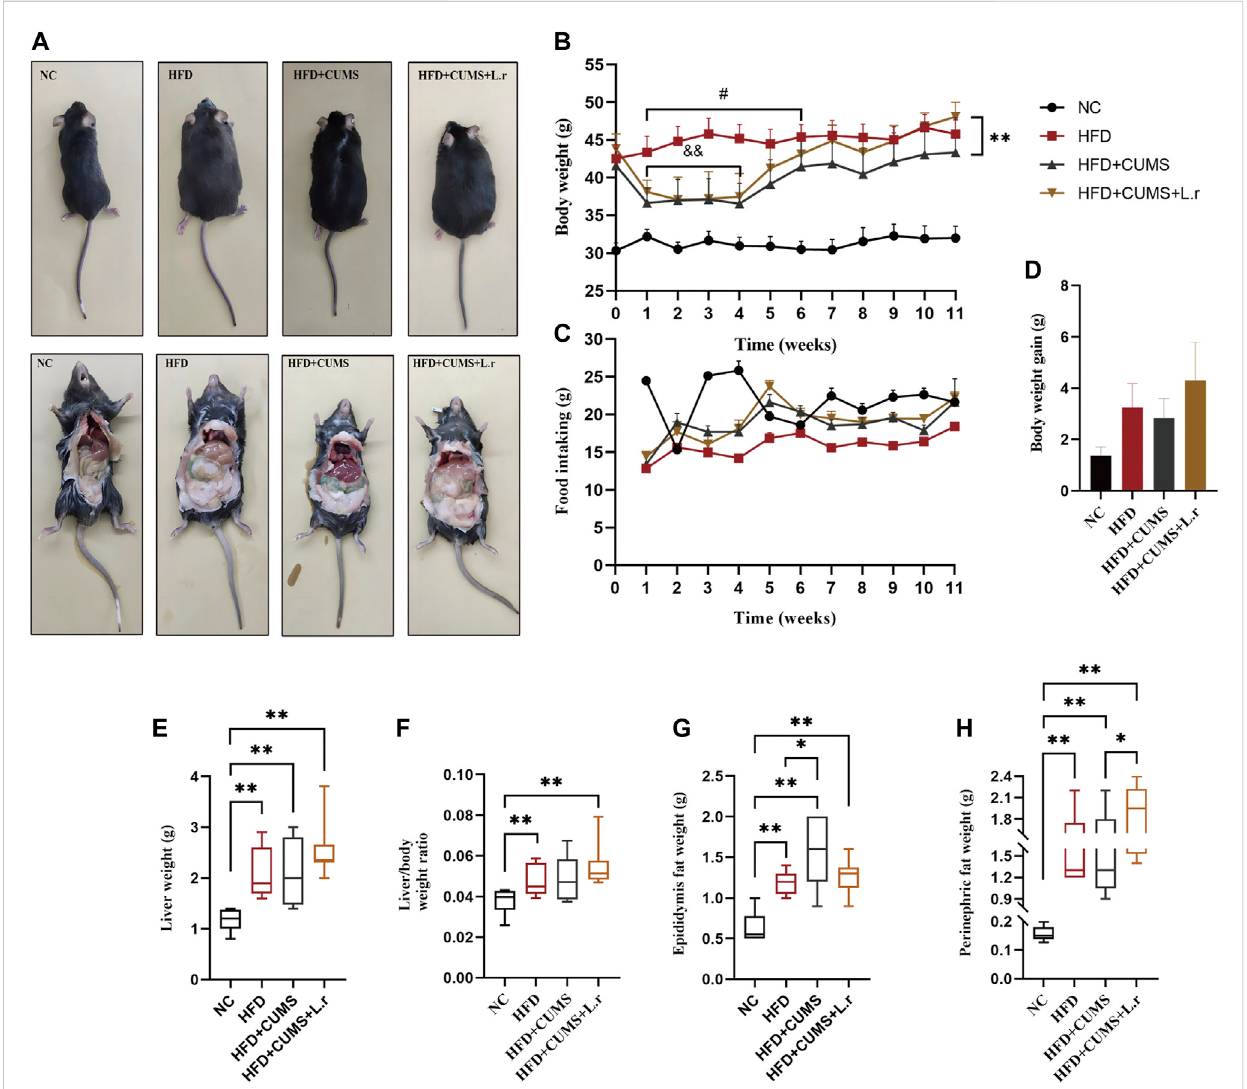
FIGURE 3 Gavaged with Lactobacillus reuteri affected the body weight in comorbid mice ( n = 8 – 10/group). (A) Body size and fat accumulation of mice. (B) Bodyweight. (C) Food intake. (D) Body weight gain. (E) Liver weight. (F) Liver/bodyweight ratio. (G) Epididymis fatweight. (H) Perinephricfatweight.Data are shown as the mean ± SEM. and& p < 0.01 vs. the HFD group; # p < 0.05 vs. the HFD + CUMS group; * p < 0.05, ** p < 0.01 (Statistical comparisons between the two groups were performed using the two independent samples t -test. Comparisons between multiple groups were performed using One-way ANOVA and Tukey